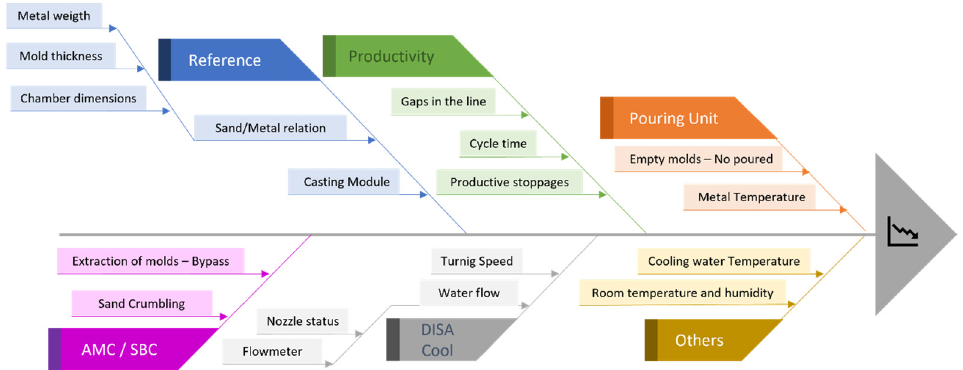
Figure 1. Ishikawa Diagram of cause–effect factors in green sand molding, collected after observa- tions of the process and the addition of expert knowledge extracted from the bibliographic studies.